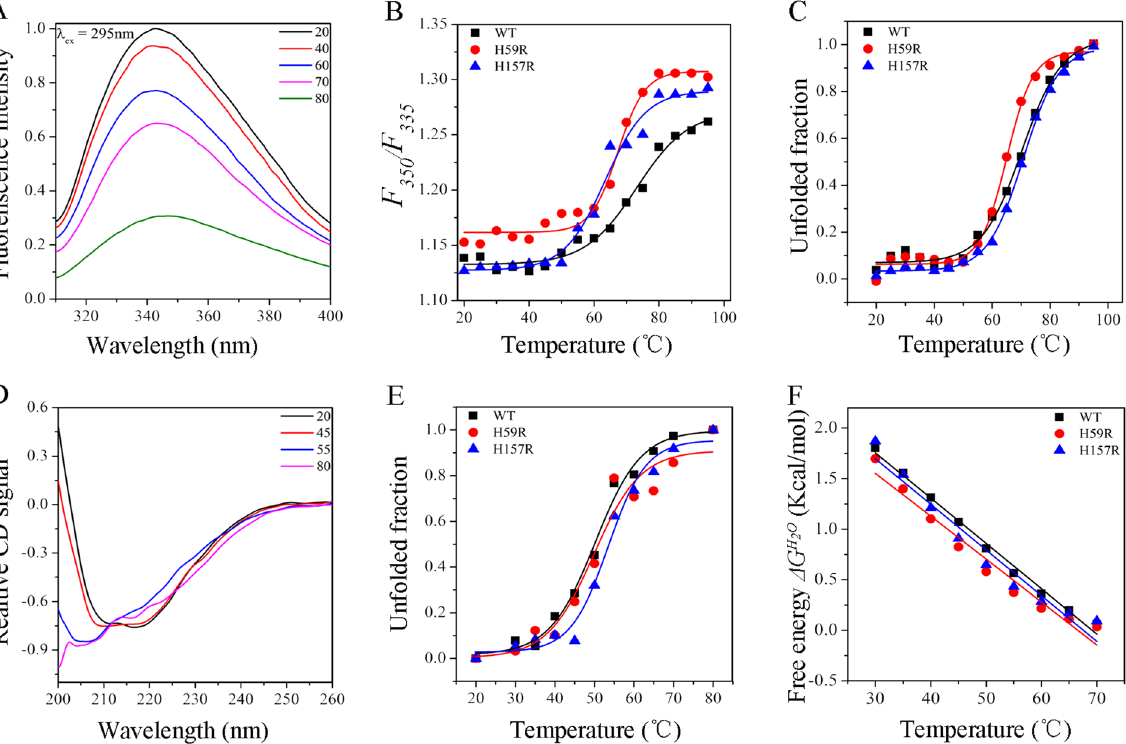
Figure 2. The thermal unfolding curves of Pin1-WT, H59R and H157R. ( A ) The representative fluorescence spectra of Pin1-WT. ( B ) The structural changes in the F 350 /F 335 ratio for the spectra of Pin1-WT, H59R and H157R. ( C ) The thermal unfolding curves of Pin1-WT, H59R and H157R on the basis of fluorescence spectra with λ ex = 295 nm. ( D ) The representative far-UV CD spectra of Pin1-WT. ( E ) The relative intensity of far-UV CD spectra of Pin1-WT, H59R and H157R at 208 nm. ( F ) The thermal unfolding curves of Pin1-WT, H59R and H157R on the basis of far-UV CD spectra.